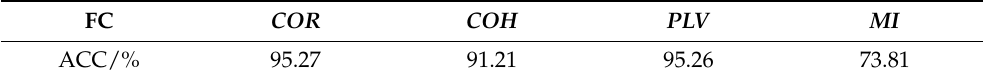
Table 2. Classification accuracy by using single FC ( COR , COH , PLV , and MI